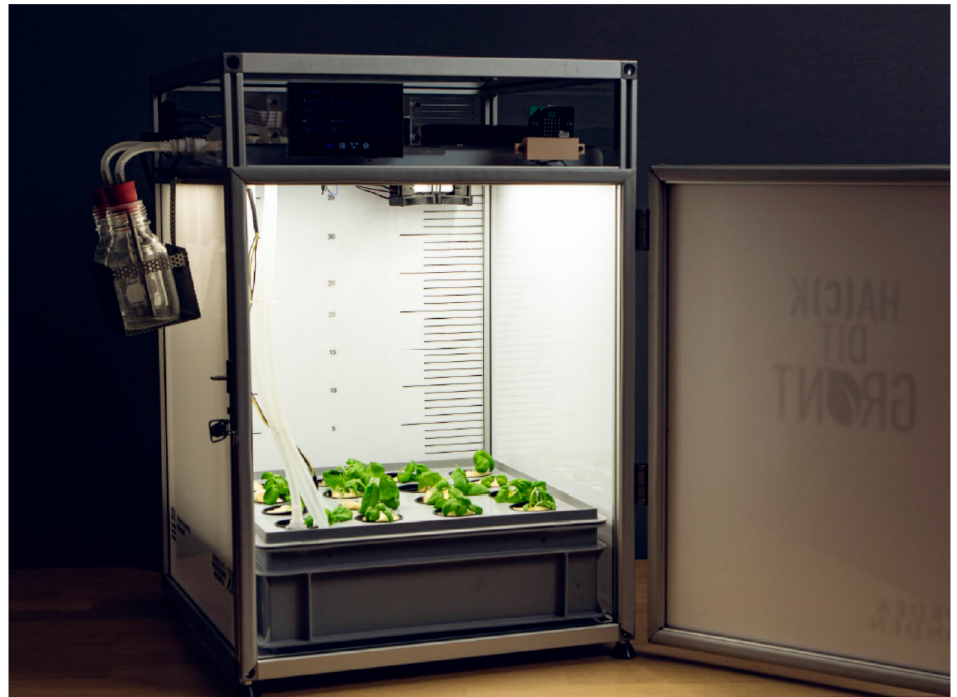
Figure 2. The GrowBot with an open door to the chamber, which contains the water tray at the bottom, and small basil plants in the cups in the tray. Water and fertilizer bottles are mounted on the side.